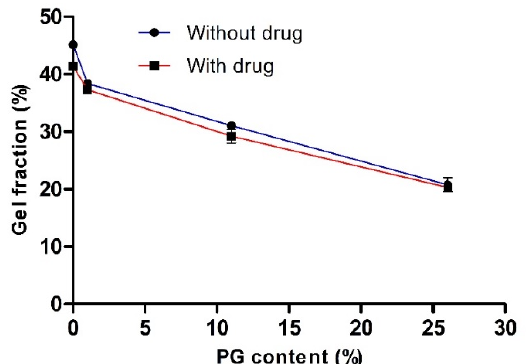
Figure 2. The effect of propylene glycol (PG) on the gel fraction (%). Data are expressed as the mean ± standard deviation ( n = 4).